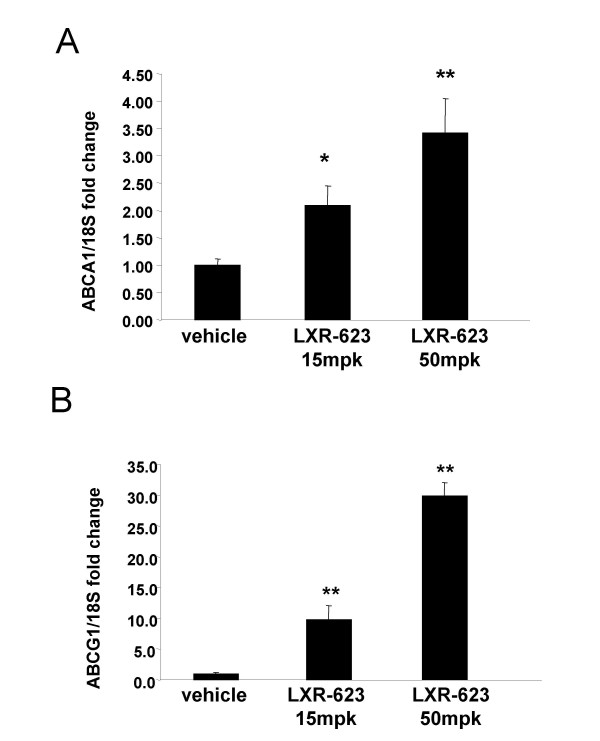
LXR-623 upregulates transcription of ABCA1 and ABCG1 in monkey whole blood cells proportional to dose. Cynomolgous monkeys maintained on normal chow were orally dosed with 0, 15 and 50 mpk/day of LXR-623 for 7 days (n = 4 per dose group). Blood was collected on day 7 of dosing, and RNA was prepared from whole blood for gene expression analysis of ABCA1 and ABCG1. qPCR was performed using assays designed to measure monkey (A) ABCA1 and (B) ABCG1 transcripts, and the measured amounts of these transcripts were normalized to monkey 18S RNA levels in each sample. Bars indicate the mean fold change of normalized ABCA1 or ABCG1 transcript levels +/- SEM in the indicated dose group compared to vehicle treated animals at the same time point. *p < 0.05, **p < 0.01 compared to vehicle treatment, as determined by Student's t test.